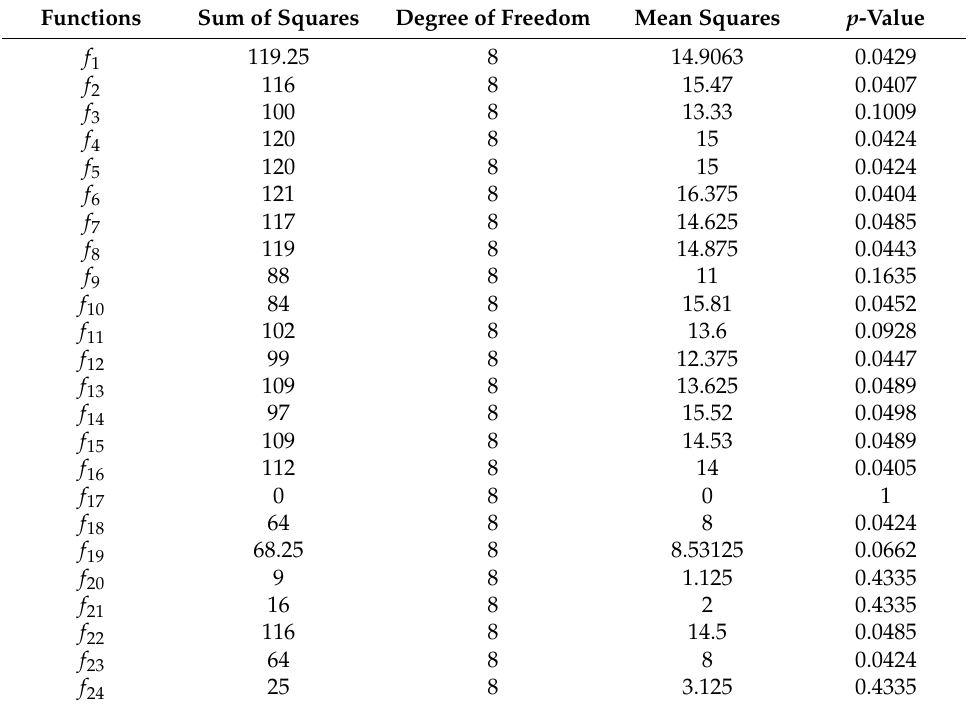
Table 9. Friedman test statistical results of nine